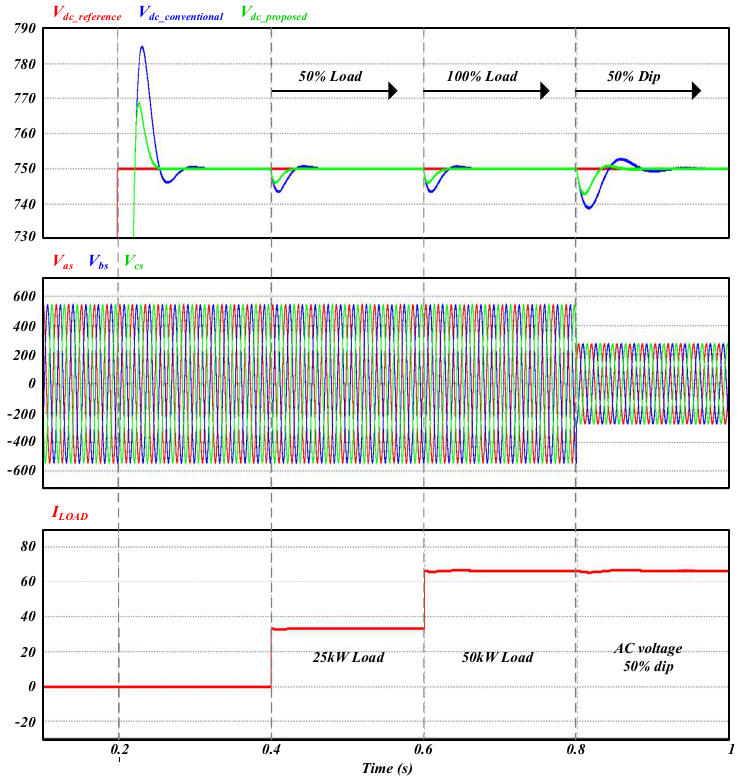
Figure 9. Comparison of the conventional method with the proposed control.